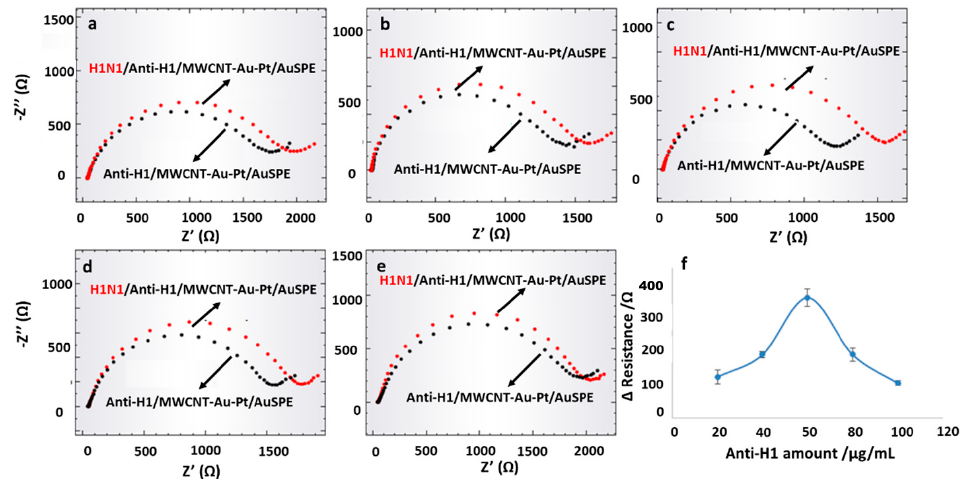
Figure 5. Nyquist plots for the electrochemical influenza A immunosensor that contained different amounts of anti-H1 antibody: ( a ) 20 µ g/mL, ( b ) 40 µ g/mL, ( c ) 60 µ g/mL, ( d ) 80 µ g/mL, ( e ) 100 µ g/mL, and ( f ) change in the resistance values towards increasing concentrations of anti-H1 antibody.